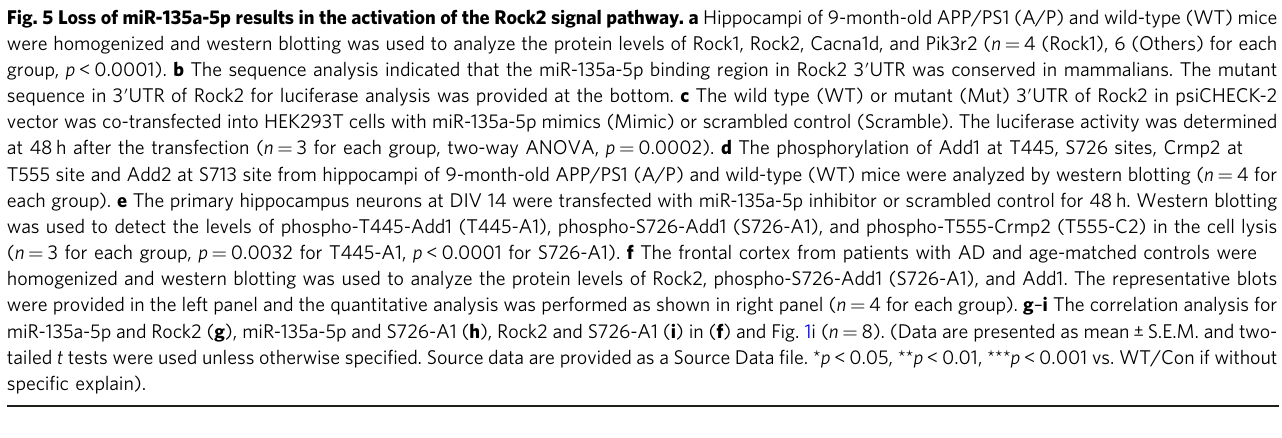
Fig. 5 Loss of miR-135a-5p results in the activation of the Rock2 signal pathway. a Hippocampi of 9-month-old APP/PS1 (A/P) and wild-type (WT) mice were homogenized and western blotting was used to analyze the protein levels of Rock1, Rock2, Cacna1d, and Pik3r2 ( n = 4 (Rock1), 6 (Others) for each group, p < 0.0001). b The sequence analysis indicated that the miR-135a-5p binding region in Rock2 3 ′ UTR was conserved in mammalians. The mutant sequence in 3 ′ UTR of Rock2 for luciferase analysis was provided at the bottom. c The wild type (WT) or mutant (Mut) 3 ′ UTR of Rock2 in psiCHECK-2 vector was co-transfected into HEK293T cells with miR-135a-5p mimics (Mimic) or scrambled control (Scramble). The luciferase activity was determined at 48 h after the transfection ( n = 3 for each group, two-way ANOVA, p = 0.0002). d The phosphorylation of Add1 at T445, S726 sites, Crmp2 at T555 site and Add2 at S713 site from hippocampi of 9-month-old APP/PS1 (A/P) and wild-type (WT) mice were analyzed by western blotting ( n = 4 for each group). e The primary hippocampus neurons at DIV 14 were transfected with miR-135a-5p inhibitor or scrambled control for 48 h. Western blotting was used to detect the levels of phospho-T445-Add1 (T445-A1), phospho-S726-Add1 (S726-A1), and phospho-T555-Crmp2 (T555-C2) in the cell lysis ( n = 3 for each group, p = 0.0032 for T445-A1, p < 0.0001 for S726-A1). f The frontal cortex from patients with AD and age-matched controls were homogenized and western blotting was used to analyze the protein levels of Rock2, phospho-S726-Add1 (S726-A1), and Add1. The representative blots were provided in the left panel and the quantitative analysis was performed as shown in right panel ( n = 4 for each group). g – i The correlation analysis for miR-135a-5p and Rock2 ( g ), miR-135a-5p and S726-A1 ( h ), Rock2 and S726-A1 ( i ) in ( f ) and Fig. 1i ( n = 8). (Data are presented as mean ± S.E.M. and two- tailed t tests were used unless otherwise speci fi ed. Source data are provided as a Source Data fi le. * p < 0.05, ** p < 0.01, *** p < 0.001 vs. WT/Con if without speci fi c